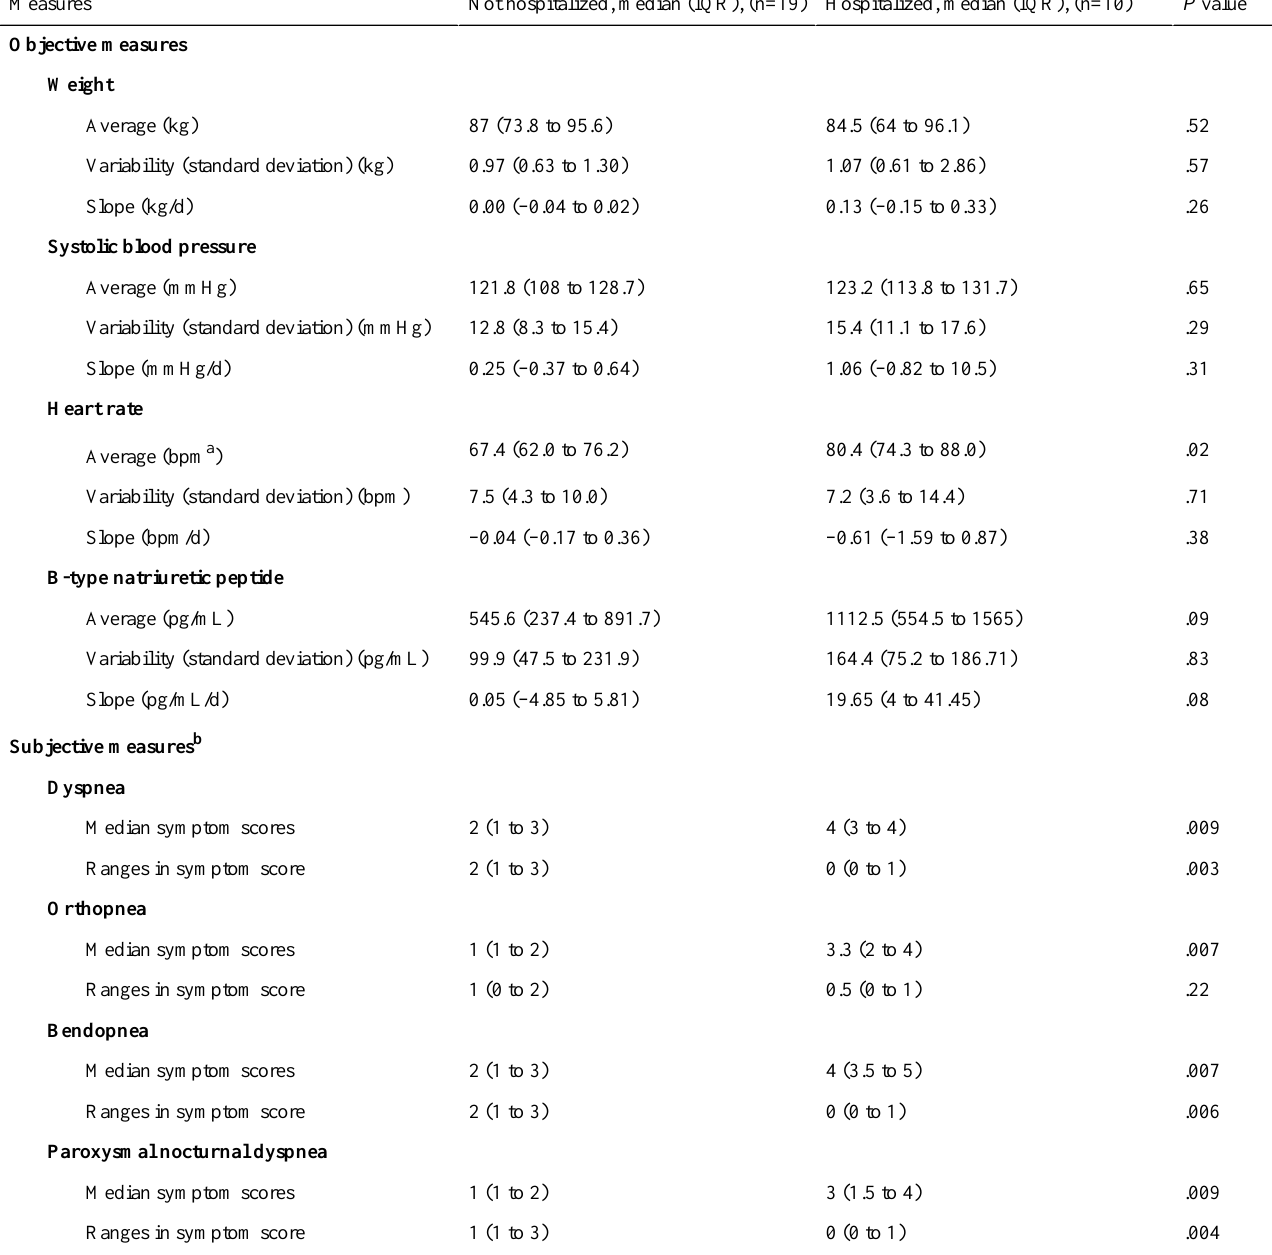
Table 3. Objective and subjective